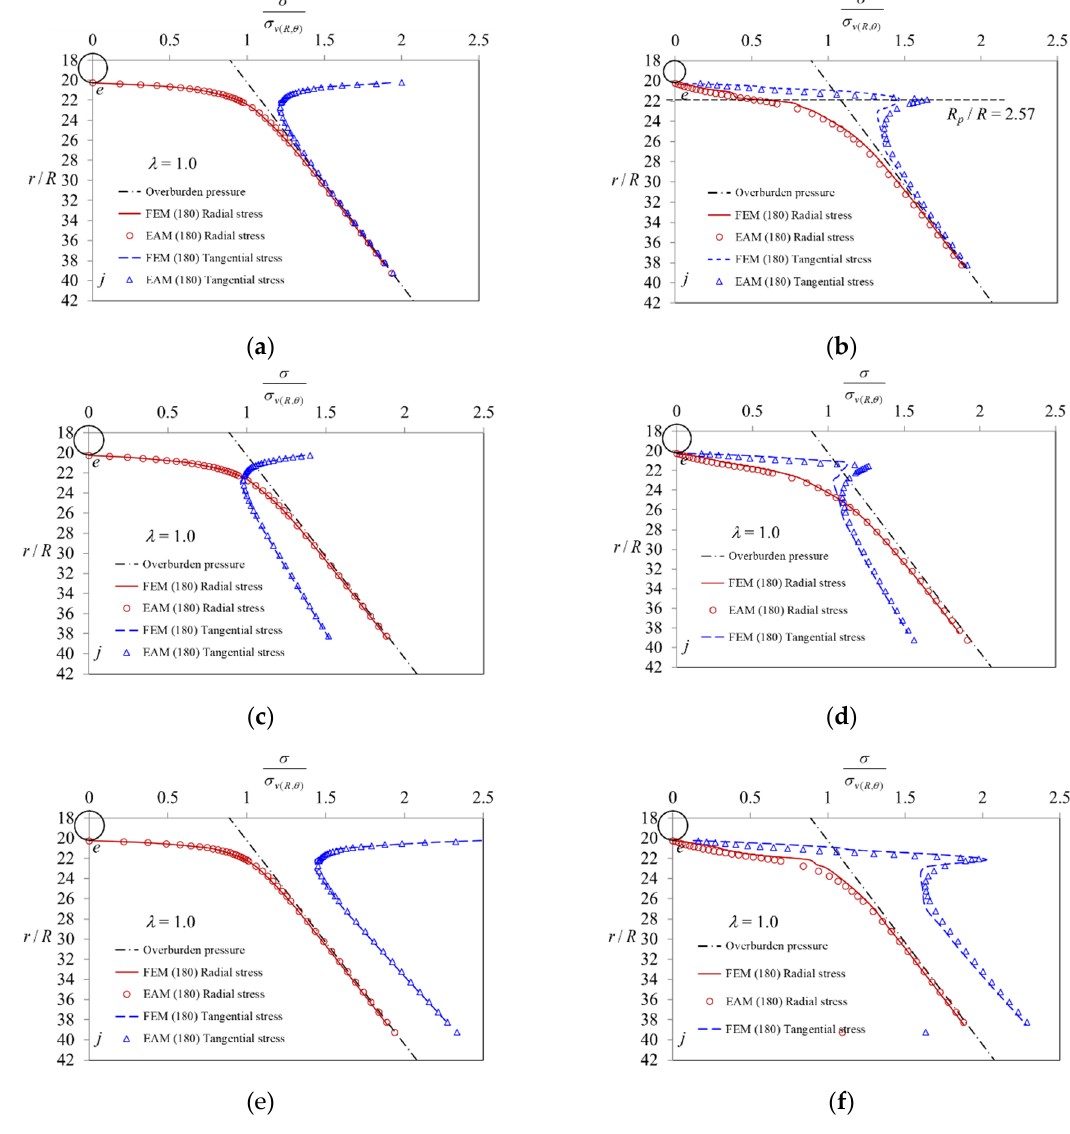
Figure 21. Ground reaction around the tunnel obtained by EAM and FEM in Case I ( θ = 180°) with λ = 1.0, and the distribution of tangential and radial stresses for ( a ) K o = 1.0 in the elastic media, ( b ) K o = 1.0 in the elastoplastic media, ( c ) K o = 0.8 in the elastic media, ( d ) K o = 0.8 in the elastoplastic media, ( e ) K o = 1.2 in the elastic media, and ( f ) K o = 1.2 in the elastoplastic media.